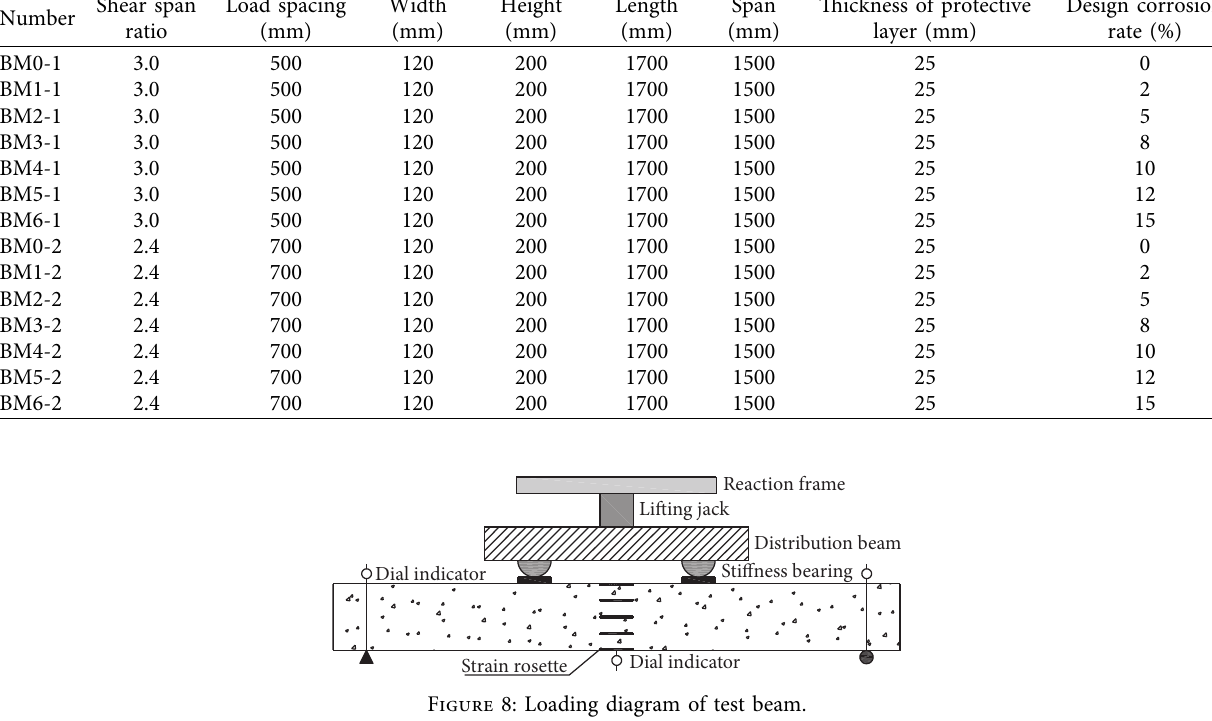
Table 2: Design parameters of experimental beams.